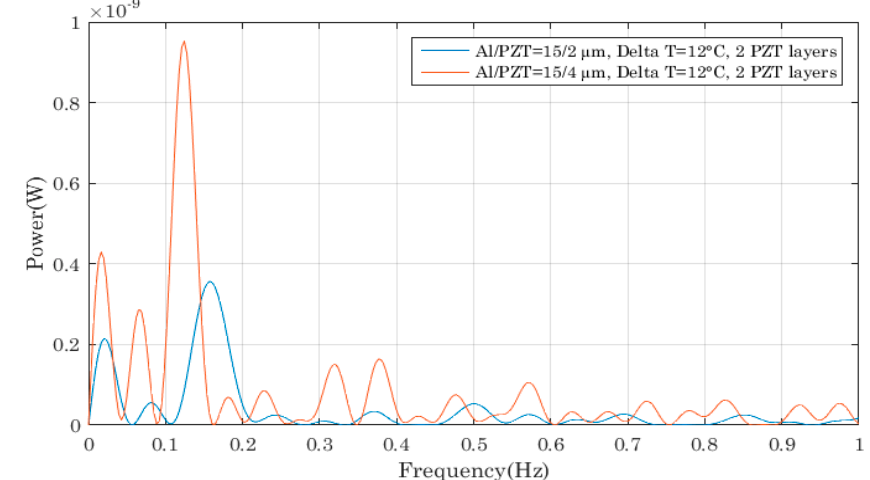
Figure 10. Impact of the PZT film thicknesses on the output power of the piezoelectric bimetal with two PZT thin films.